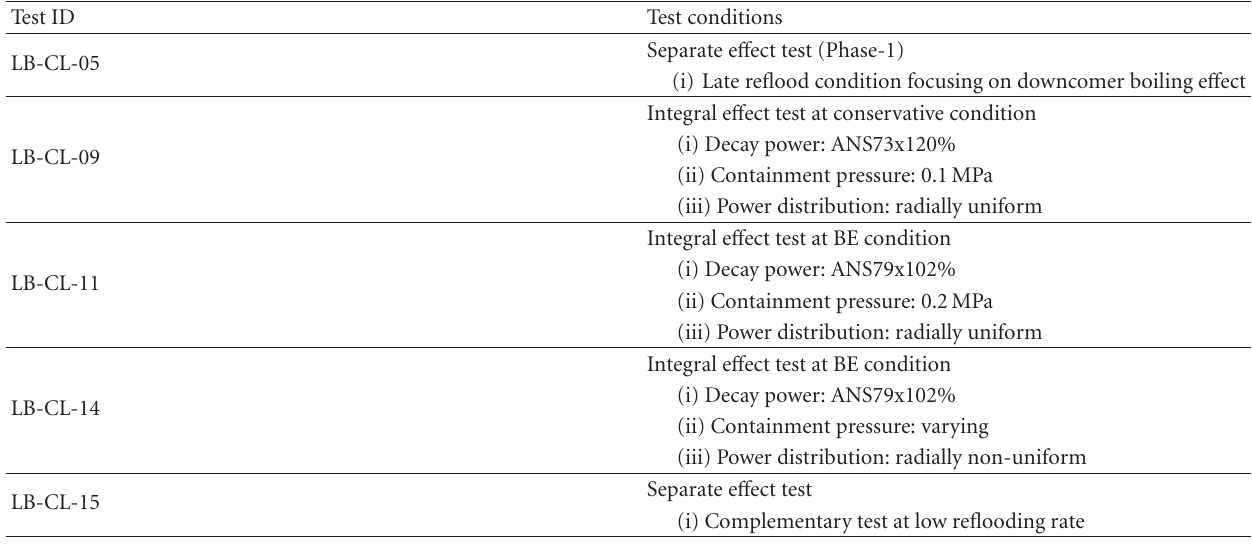
Table 2: Key test matrix for the LBLOCA reflood tests.